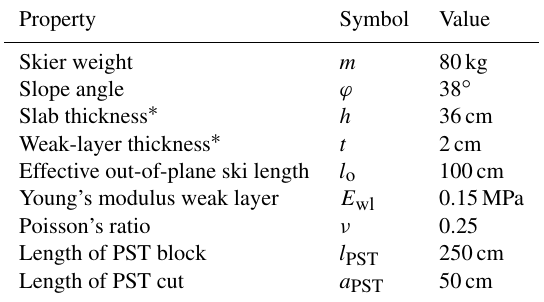
Table 2. Material properties used throughout this work unless spec- ified differently.